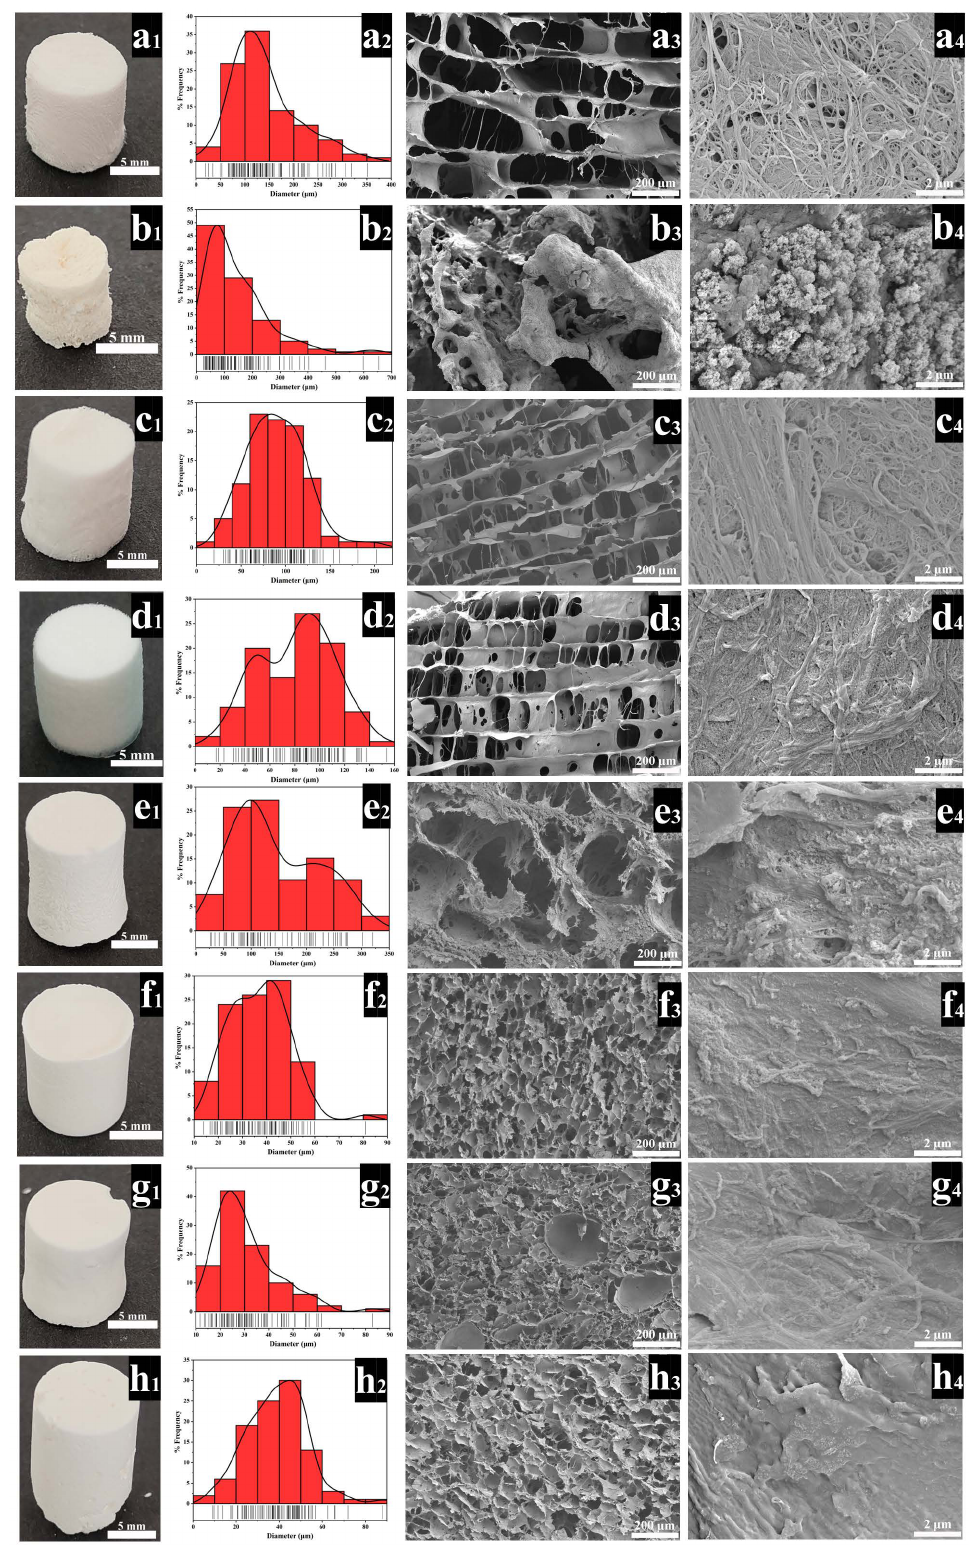
Figure 2. The actual image, the pore size distribution, the SEM image magnified 100 times, and the scaffolds magnified 10 K times, respectively, are shown from left to right: ( a1 – a4 ) F-A-T0, ( b1 – b4 ) P-A-T3, ( c1 – c4 ) F-A-T3, ( d1 – d4 ) F-A-T5, ( e1 – e4 ) F-B-T5-P0, ( f1 – f4 ) F-B-T5-P0.5, ( g1 – g4 ) F-B-T5-P1.5, ( h1 – h4 )